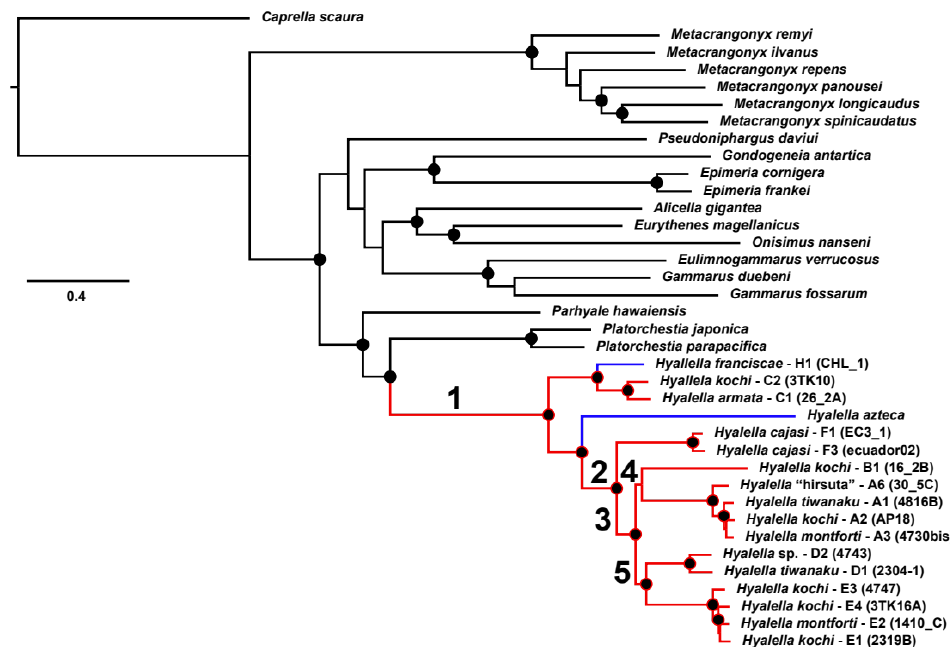
Figure 1. Maximum likelihood phylogeny. Phylogeny based on the concatenated 13 mitochondrial protein-coding genes (PCGs) of Hyalella and other amphipod genera (see Table S1 for details). Nodes with bootstrap support ≥ 98 are indicated with black circles. The Hyalella lineage is indicated with red branches, except for the taxa dwelling at low altitude in blue. Numbers on nodes indicate branches individually used as foreground for selection analyses.